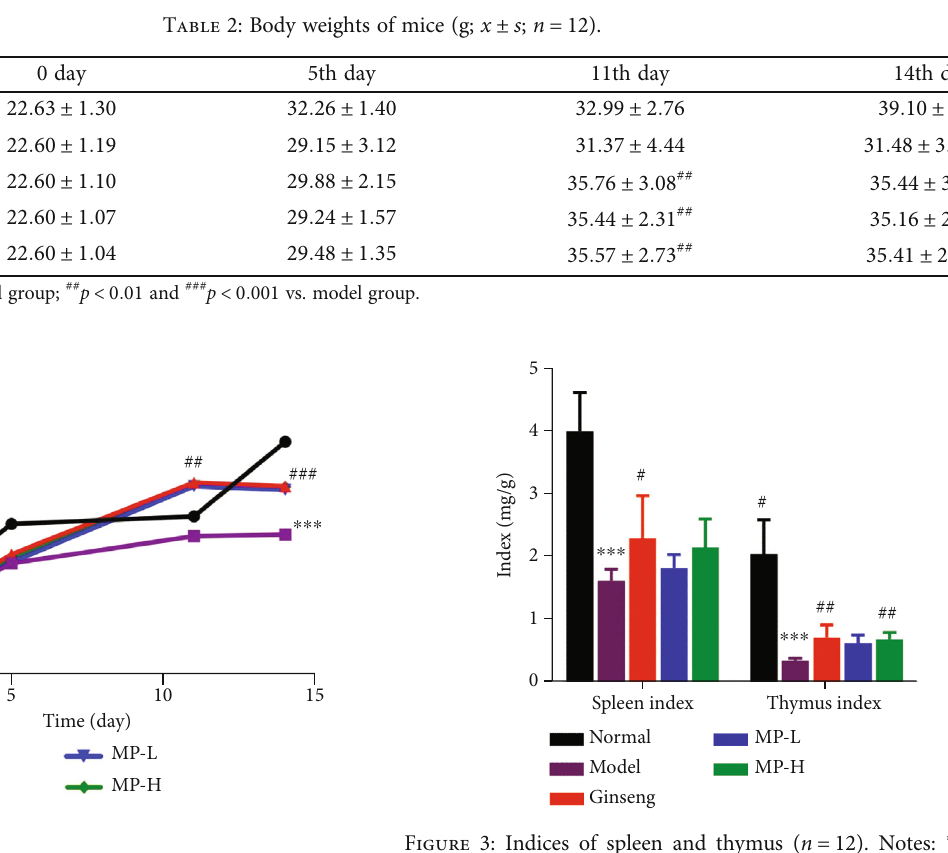
Figure 2: Body weights of mice ( n = 12 ). Notes: ∗∗∗ p < 0 : 001 vs. control group; # p < 0 : 05 and ## p < 0 : 01 vs. model group.